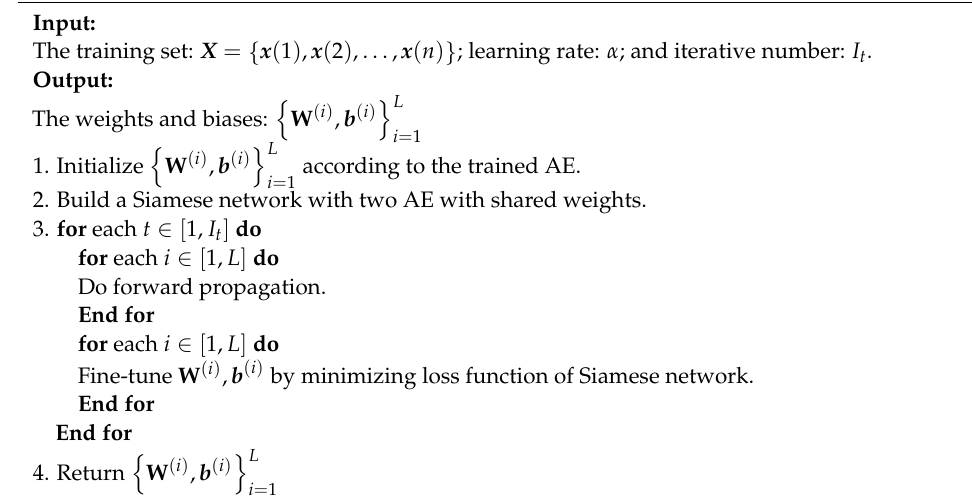
Algorithm 1. The training procedure for AE + Siamese Network.